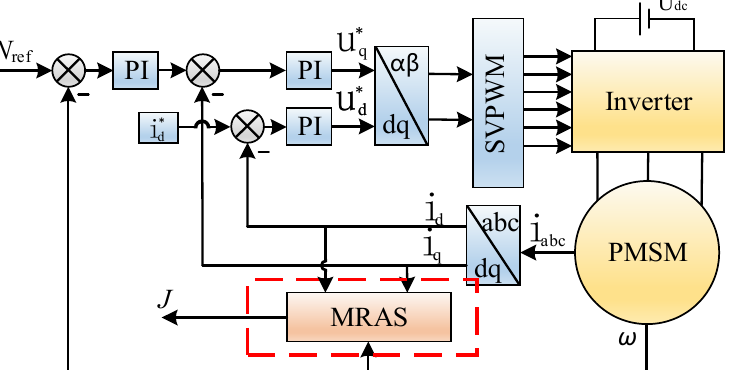
Figure 2. The closed loop control system of PMSM.